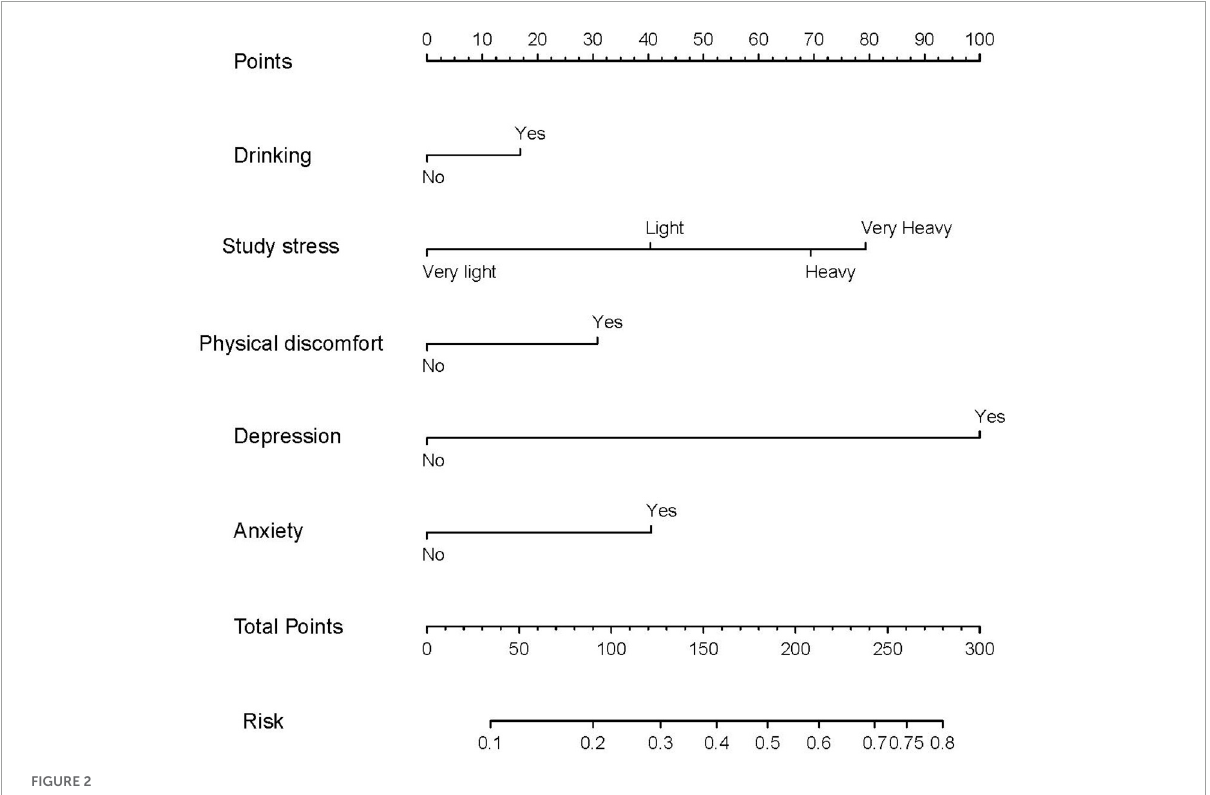
FIGURE2 The prediction nomograms of risk factors for poor sleep quality in medical students.